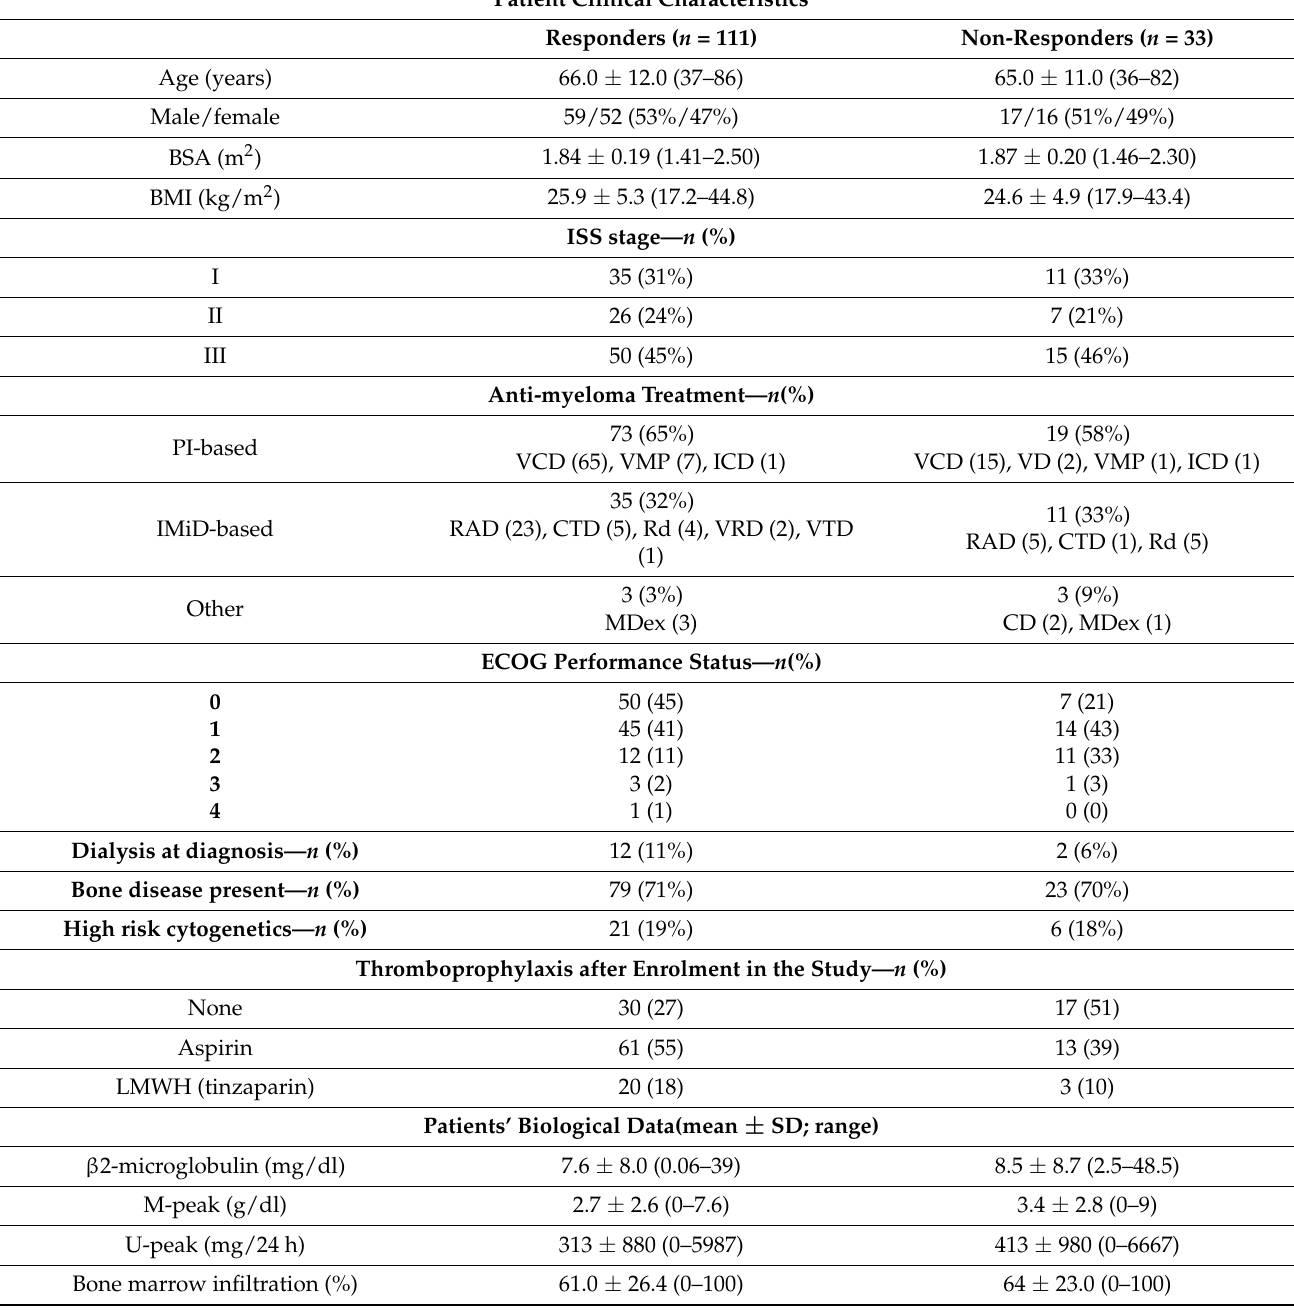
Table 1. Baseline demographic, clinical, and routine biological data of multiple myeloma